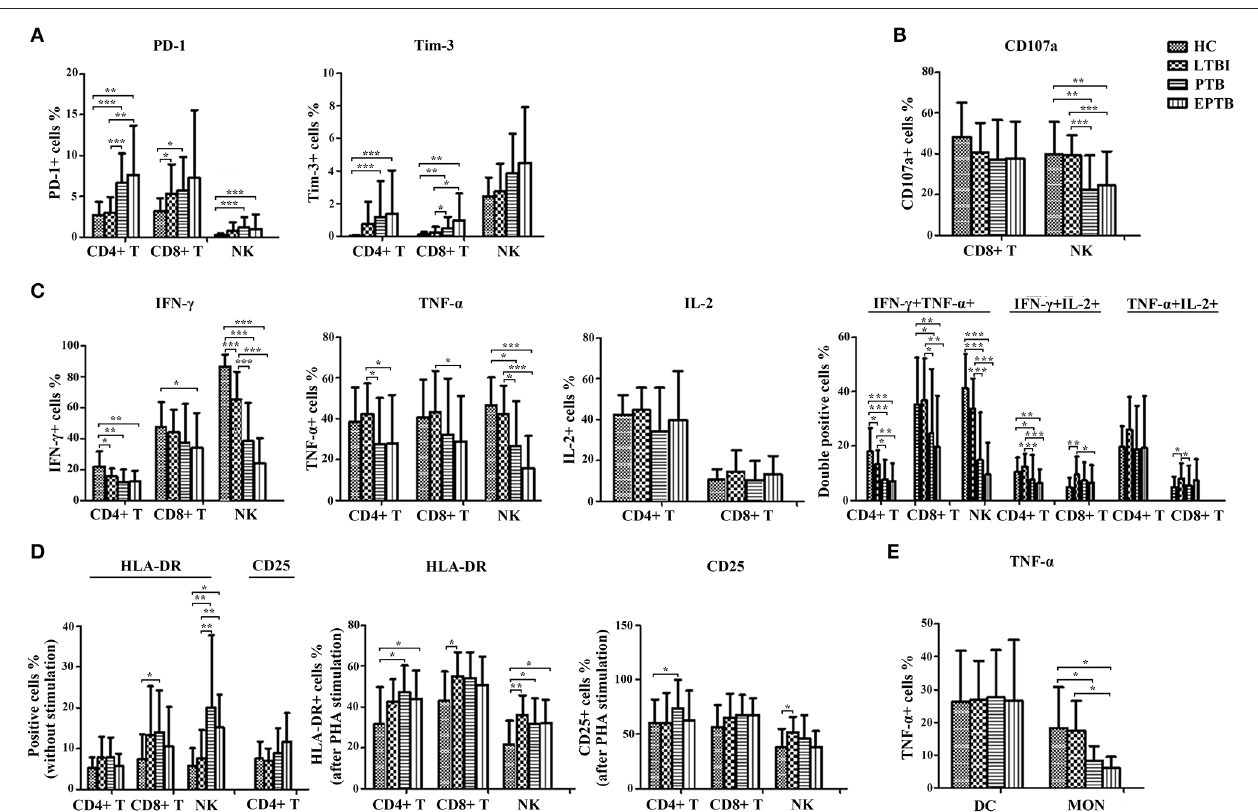
FIGURE 2 | The statistical results of the expression of non-specific immunological markers. Samples of peripheral blood were collected from HC ( n = 20), LTBI ( n = 38), PTB ( n = 32), and EPTB ( n = 37). The percentages of indicators on different immune cells were analyzed by flow cytometry. Results are expressed as the mean ± SD. (A) The percentages of PD-1 + and Tim-3 + CD4 + T, CD8 + T and NK cells in different groups were shown (without stimulation). (B) The percentages of CD107a + CD8 + T and NK cells in different groups were shown (PMA stimulation). (C) The percentages of single IFN- γ + , TNF- α + , IL-2 + , or IFN- γ + /TNF- α + , IFN- γ + /IL-2 + , TNF- α + /IL-2 + CD4 + T, CD8 + T and NK cells in different groups were shown (PMA stimulation). (D) The percentages of HLA-DR + and CD25 + CD4 + T, CD8 + T and NK cells in different groups were shown (without stimulation or PHA stimulation). (E) The percentages of TNF- α + DC and MON in different groups were shown (LPS stimulation). * p < 0.05, ** p < 0.01, *** p < 0.001. HC, healthy controls; LTBI, latent tuberculosis infection; ATB, active tuberculosis; PTB, pulmonary tuberculosis; EPTB, extrapulmonary